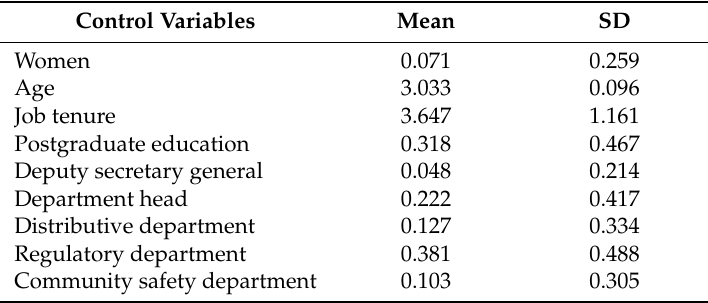
Table 2. Descriptive